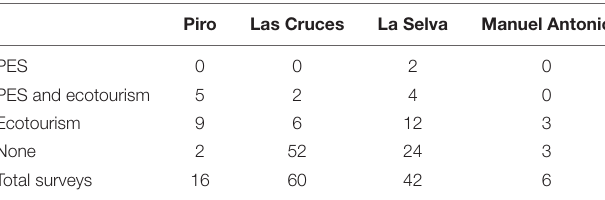
TABLE 2 | Landowner survey results ( n = 124) recording participation in conservation strategies across four regions in Costa Rica. Piro Las Cruces La